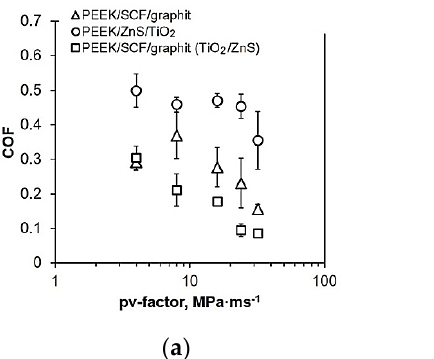
( b ) Figure 18. A schematic diagram of TF formation upon sliding of the ‘PI + SCF + PTFE’ and ‘PI + AP + PTFE’ composites on the copper counterpart surface under DSF ( a ) and SWL ( b ) conditions. The transfer process of PI composites to Cu surface consists of three steps: (i) initial transfer of wear debris, (ii) accumulation and removal of wear debris and (iii) compaction of wear debris. Figure is reproduced with permission from reference [149]. 4.4. Nanofillers In [151] Lin, L., et al. studied the role of nanoparticles on the tribological perfor- mance of PEEK-based composites. For example, these inclusions released from the ‘PEEK